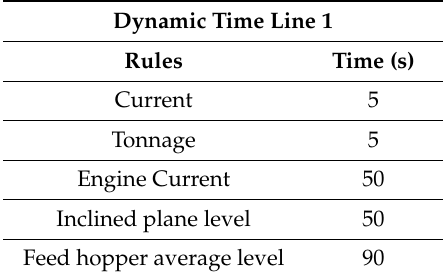
Table 4. Dynamic times K-UCN, Secondary